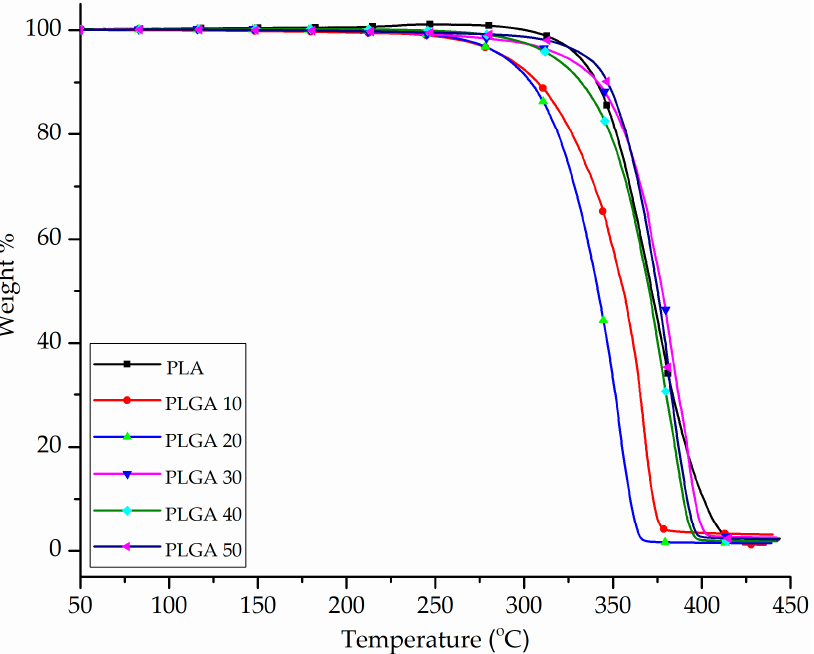
Figure 3. The thermogravimetric analysis (TGA) thermograms of the thermal stability of the PLA homo- and PLGA co-polymers with different chemical compositions.